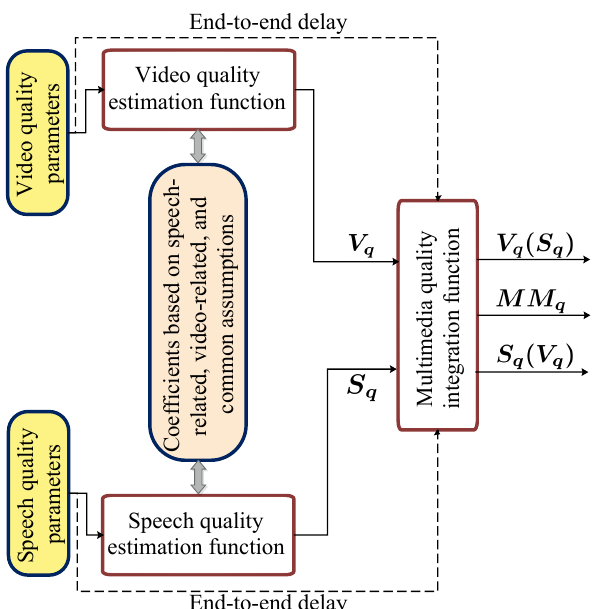
Figure 20. Multimedia communication quality assessment model (Adapted from